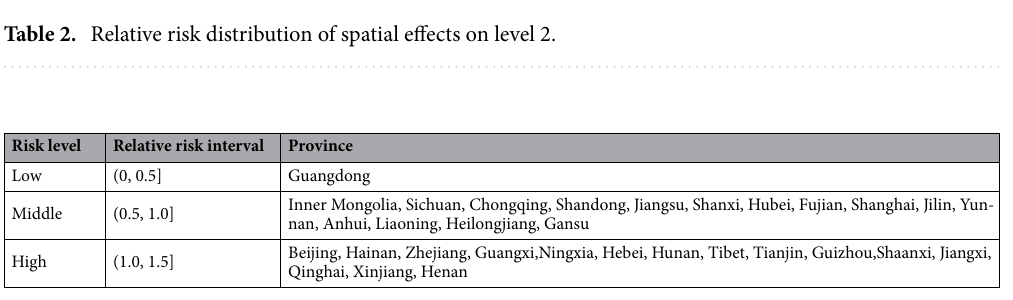
Table 3. Relative risk distribution for the combination of spatial effects on both